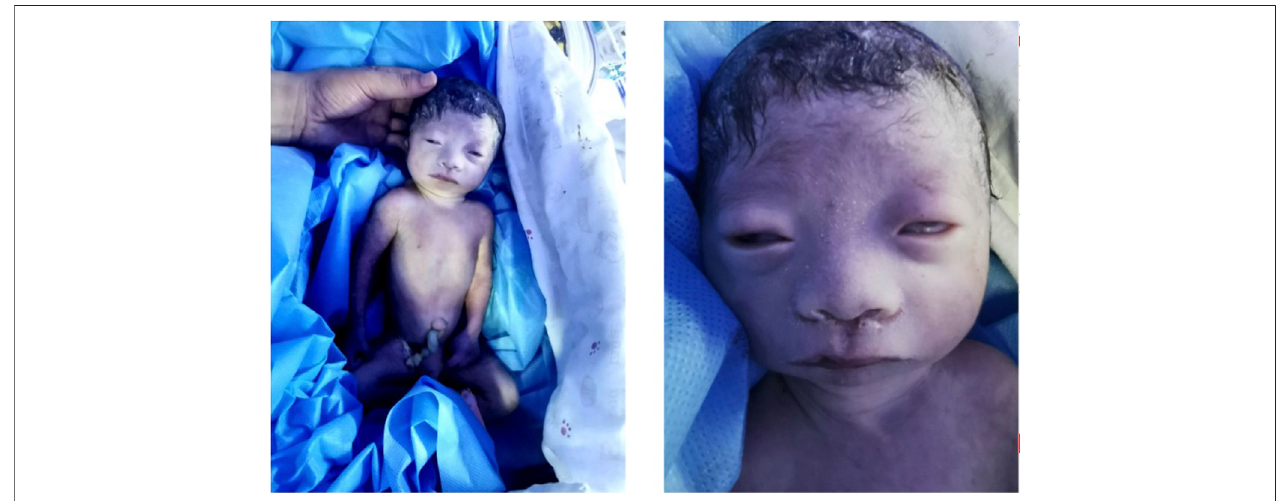
FIGURE 1 | Clinical features. The baby had hypotonia, widely spaced eyes, sparse eyelashes, small lower jaw, wide nasal bridge, wide mouth with downturned corners and low-set ears.